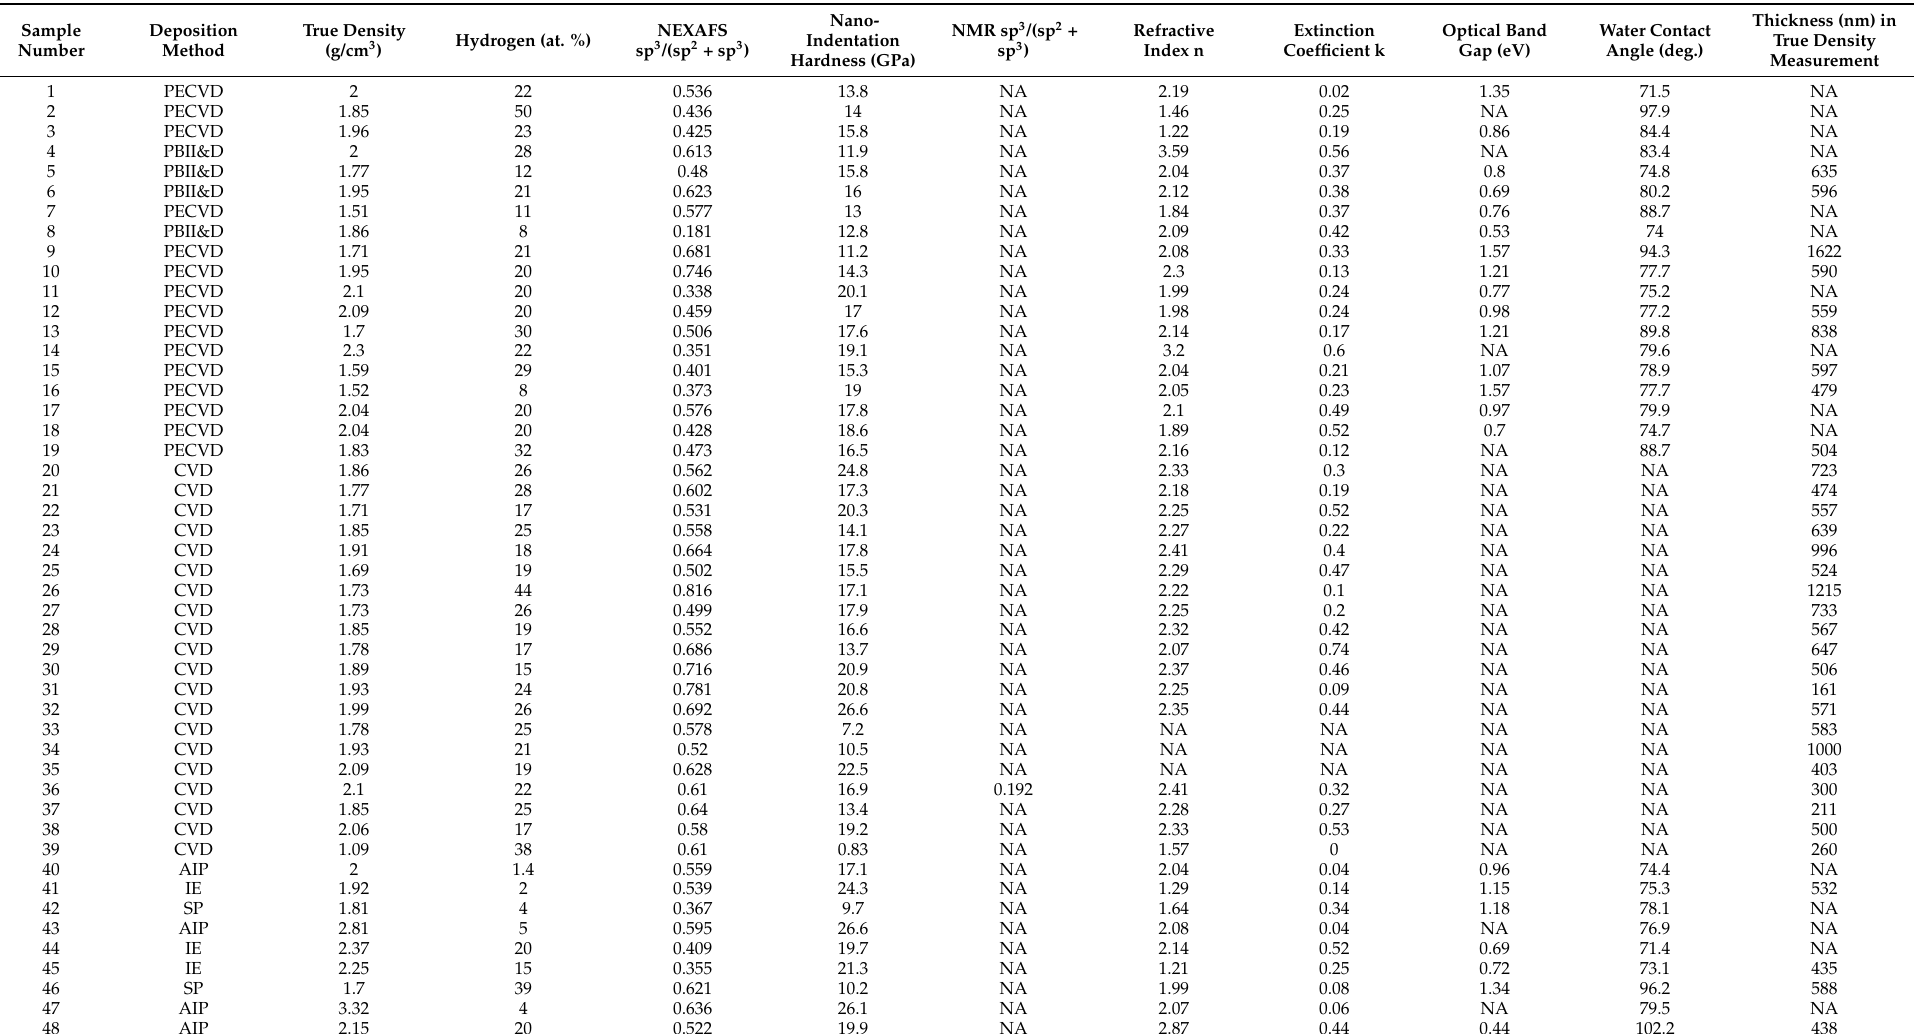
Table 2. Analyses and test results of 74 types of amorphous carbon films: 35 films were deposited by PVD, and the other 39 films were deposited by